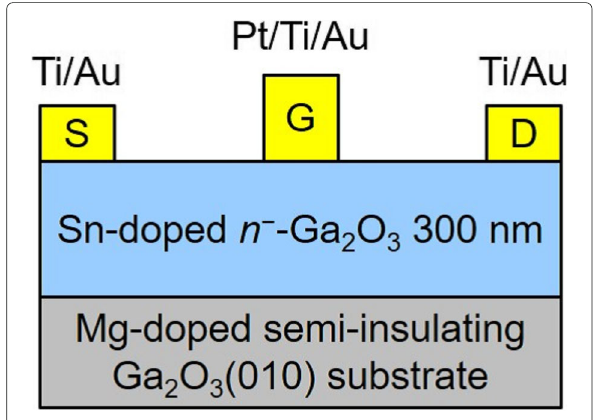
Fig. 9 Schematic cross section of Ga 2 O 3 MESFET. Adapted with permission [3]. Copyright 2012,